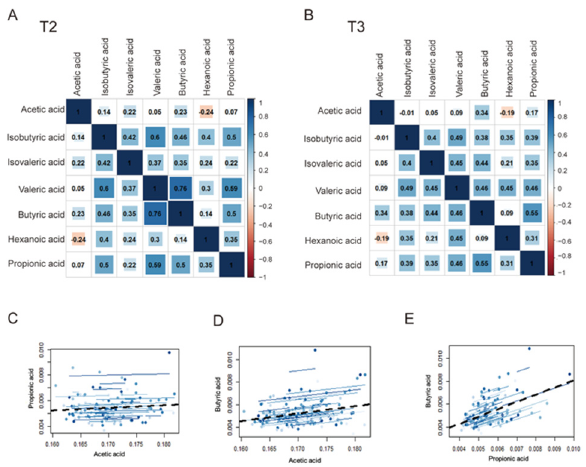
Figure 2. Relationships between SCFAs. ( A , B ) Correlation analysis between SCFAs in all pregnancies in T2 and T3. ( C – E ) Dynamic trajectory analysis between butyric acid and acetic or propionic acid in all pregnancies.